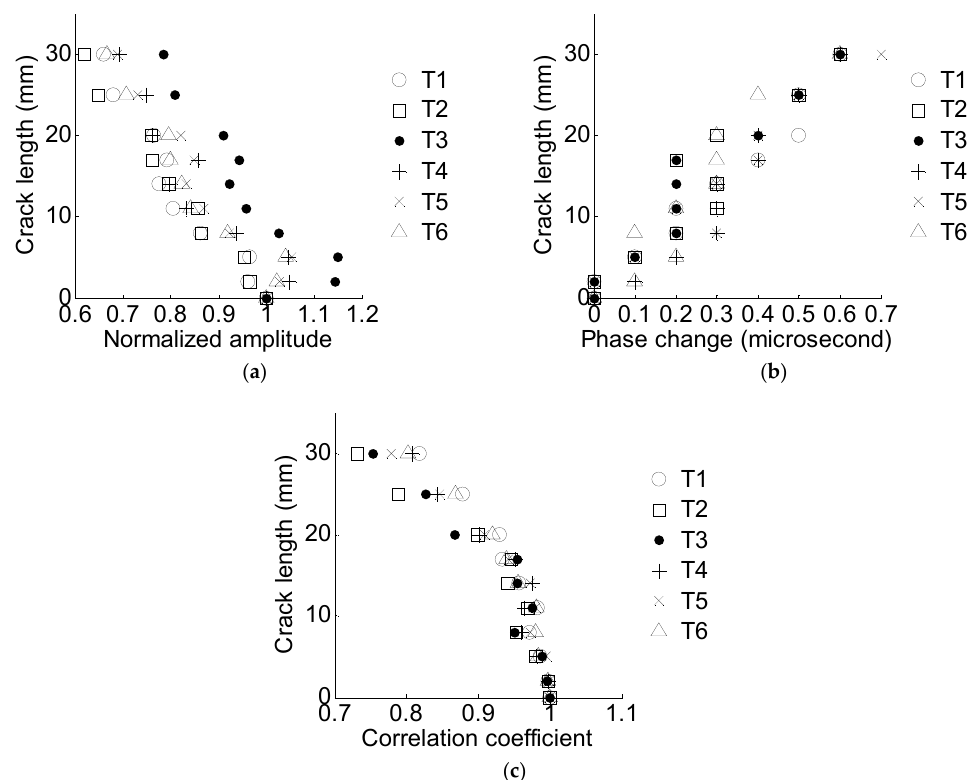
Figure 12. Crack length versus the damage sensitive features for six specimens. ( a ) Crack length versus the normalized amplitude; ( b ) crack length versus the phase change; ( c ) crack length versus the correlation coefficient.